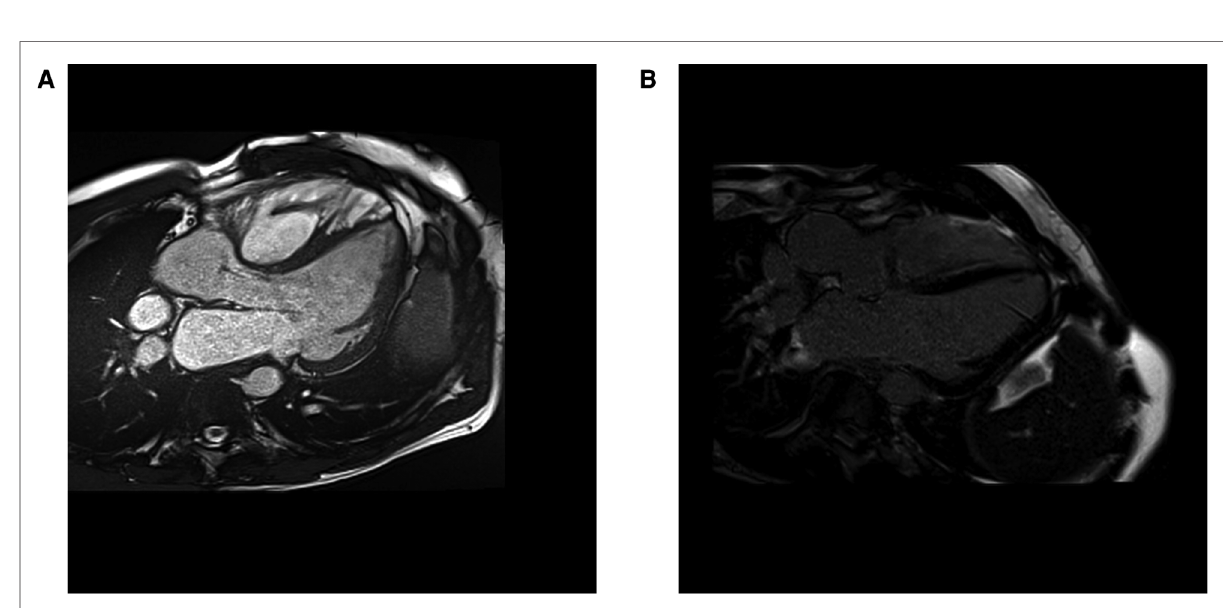
FIGURE 4 CMR cine 3 chamber view ( A ) and LGE image ( B ) from a 39 years old patient with a repaired tetralogy of Fallot, showing focal fi brosis in the anterior wall of the right